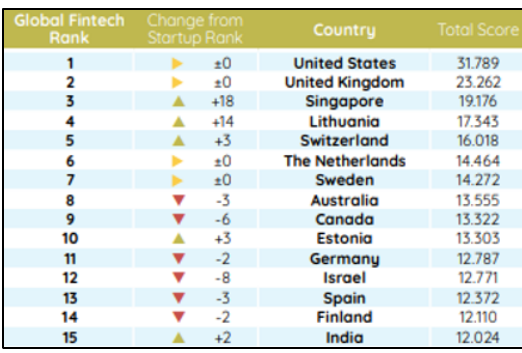
Table. 1. FinTech Country Ranking